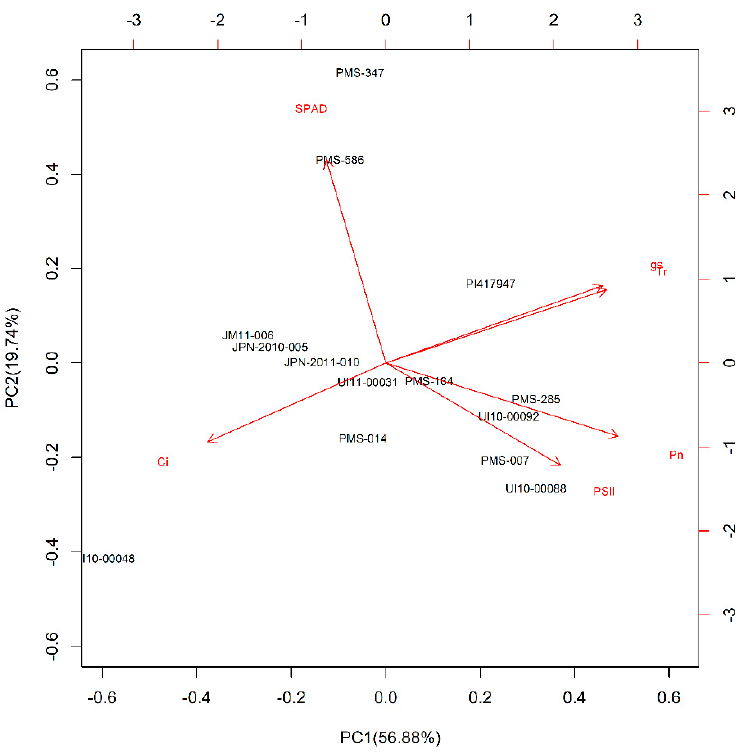
Figure 2. Principal component analysis (PCA) bi-plot of drought stress index (DSI) of six physiological traits (photosynthetic rate (Pn), stomatal conductance (gs), transpiration rate (Tr), intercellular CO 2 concentration (Ci), the Soil Plant Analysis Development (SPAD) Chlorophyll meter value, and chlorophyll fluorescence (PSII)) under drought over a 14-day period in screening experiment at Brigham Young University, Provo, UT, USA. Arrows represent physiological traits with various lengths, which were based on the impact of each trait on the separation of genotypes.